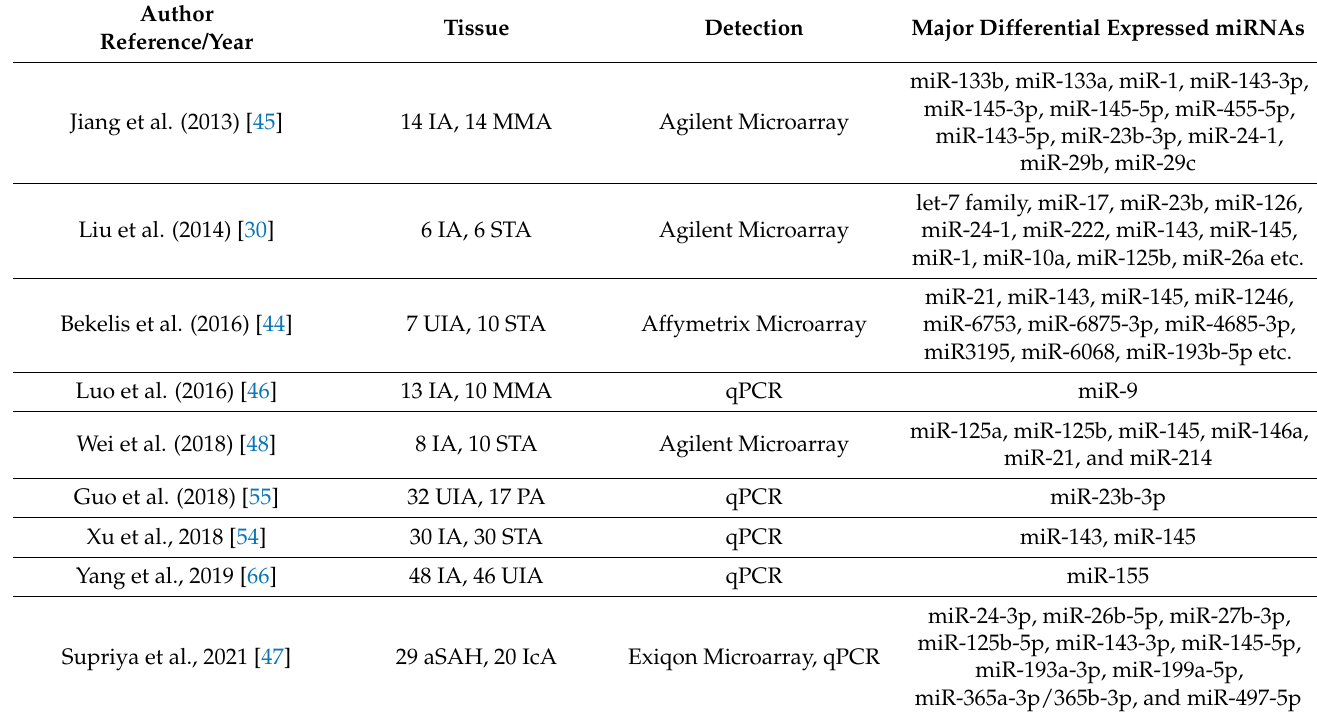
Table 1. Differential miRNA expression in human IA